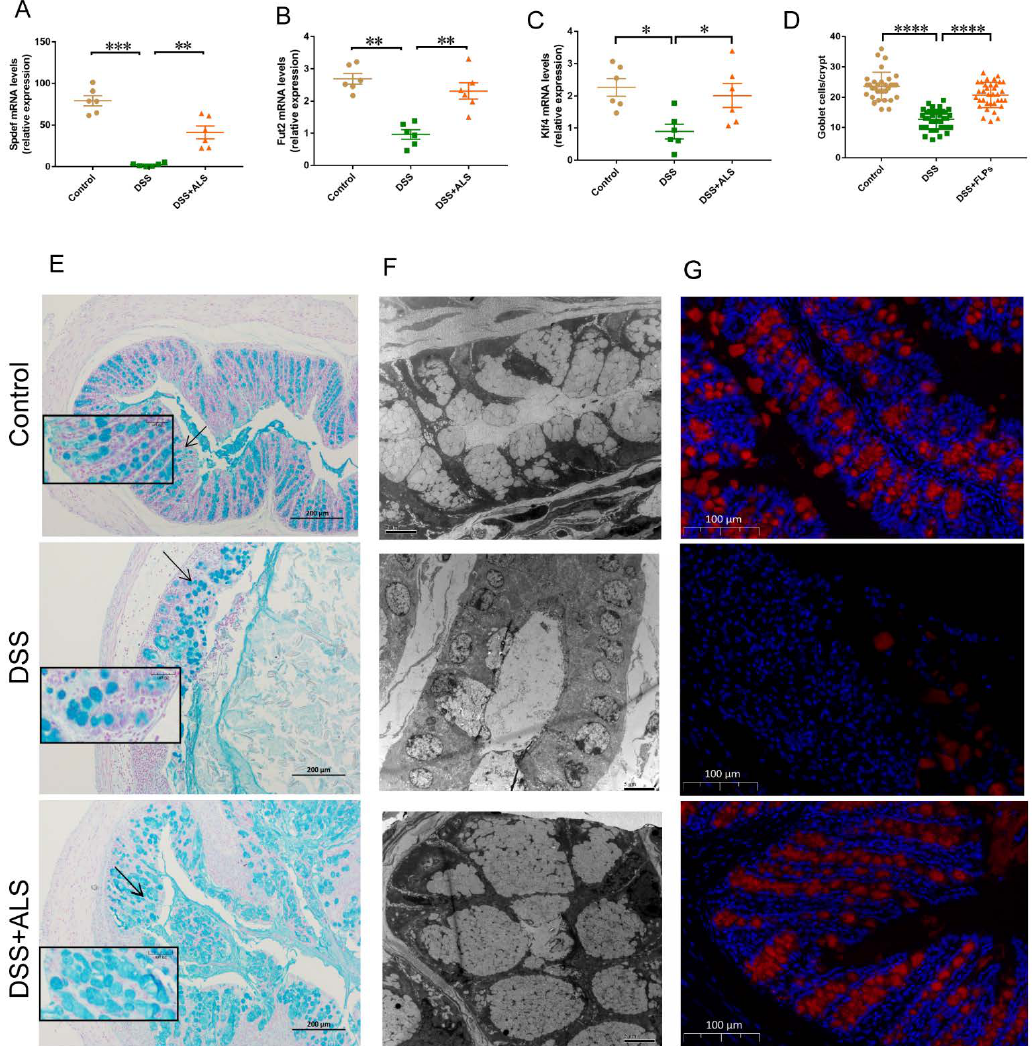
Figure 3. ALS recovers the intestinal goblet loss. ( A – C ) The expression of genes related to goblet cell differentiation examined by real-time PCR assay. ( D ) The number of goblet cells was quantified. ( E ) Representative pictures of alcian blue-stained colon. Scale bar = 200 µ m. ( F ) Representative TEM images of the mucin granules in colon. Scale bar = 5 µ m. ( G ) Representative pictures of immunofluorescence of Muc2 in colon tissues. Scale bar = 100 µ m. Data are mean ± SEM. n = 5–6 mice per group. * p < 0.05, ** p < 0.01, *** p < 0.001 and **** p <